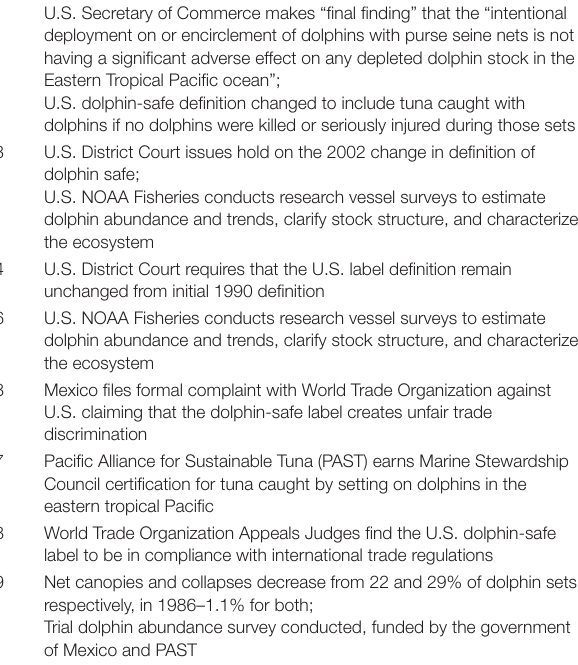
TABLE 1 | Timeline of significant events associated with mitigation of dolphin mortality in the yellowfin tuna purse-seine fishery of the eastern tropical